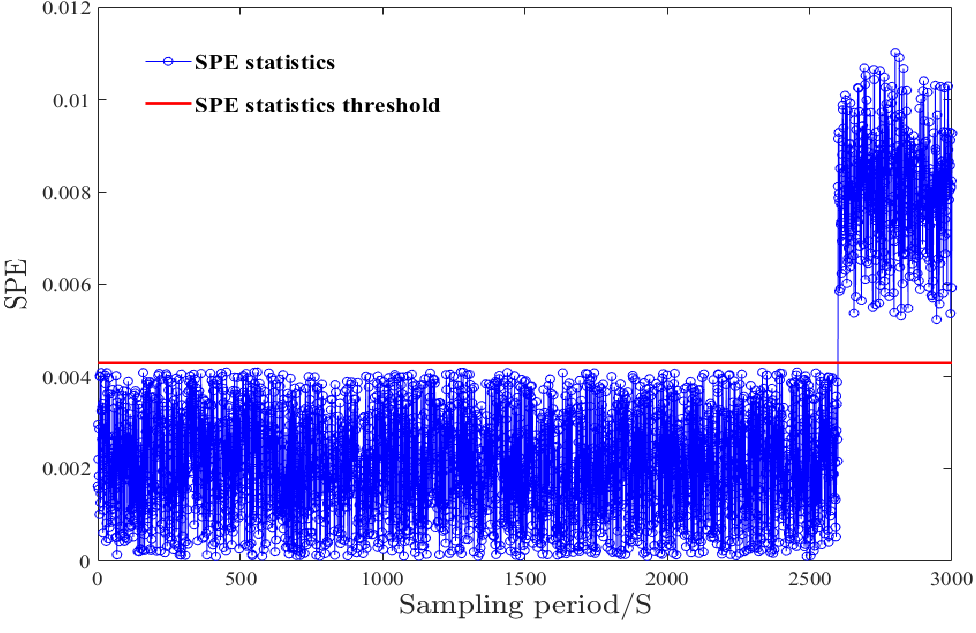
Figure 5. Value of SPE statistic under the condition of LPC fault.